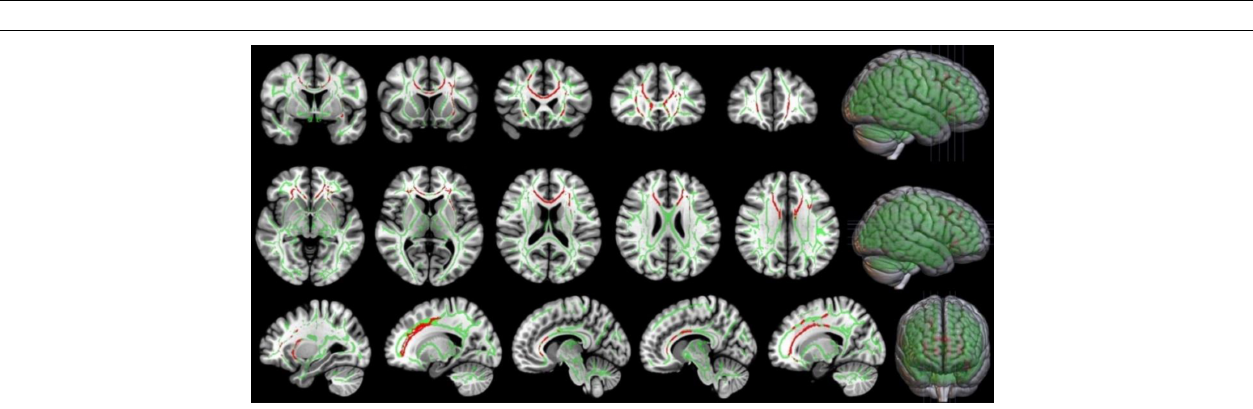
FIGURE 4 | Pearson analysis of neuropsychological scale score and gray matter density in the left Temporal Mid and Frontal_Med_Orb after chronic hypoxia exposure at high altitude ( p < 0.05). MoCA, montreal cognitive assessment scale; RAVLT, rey auditory verbal learning test.